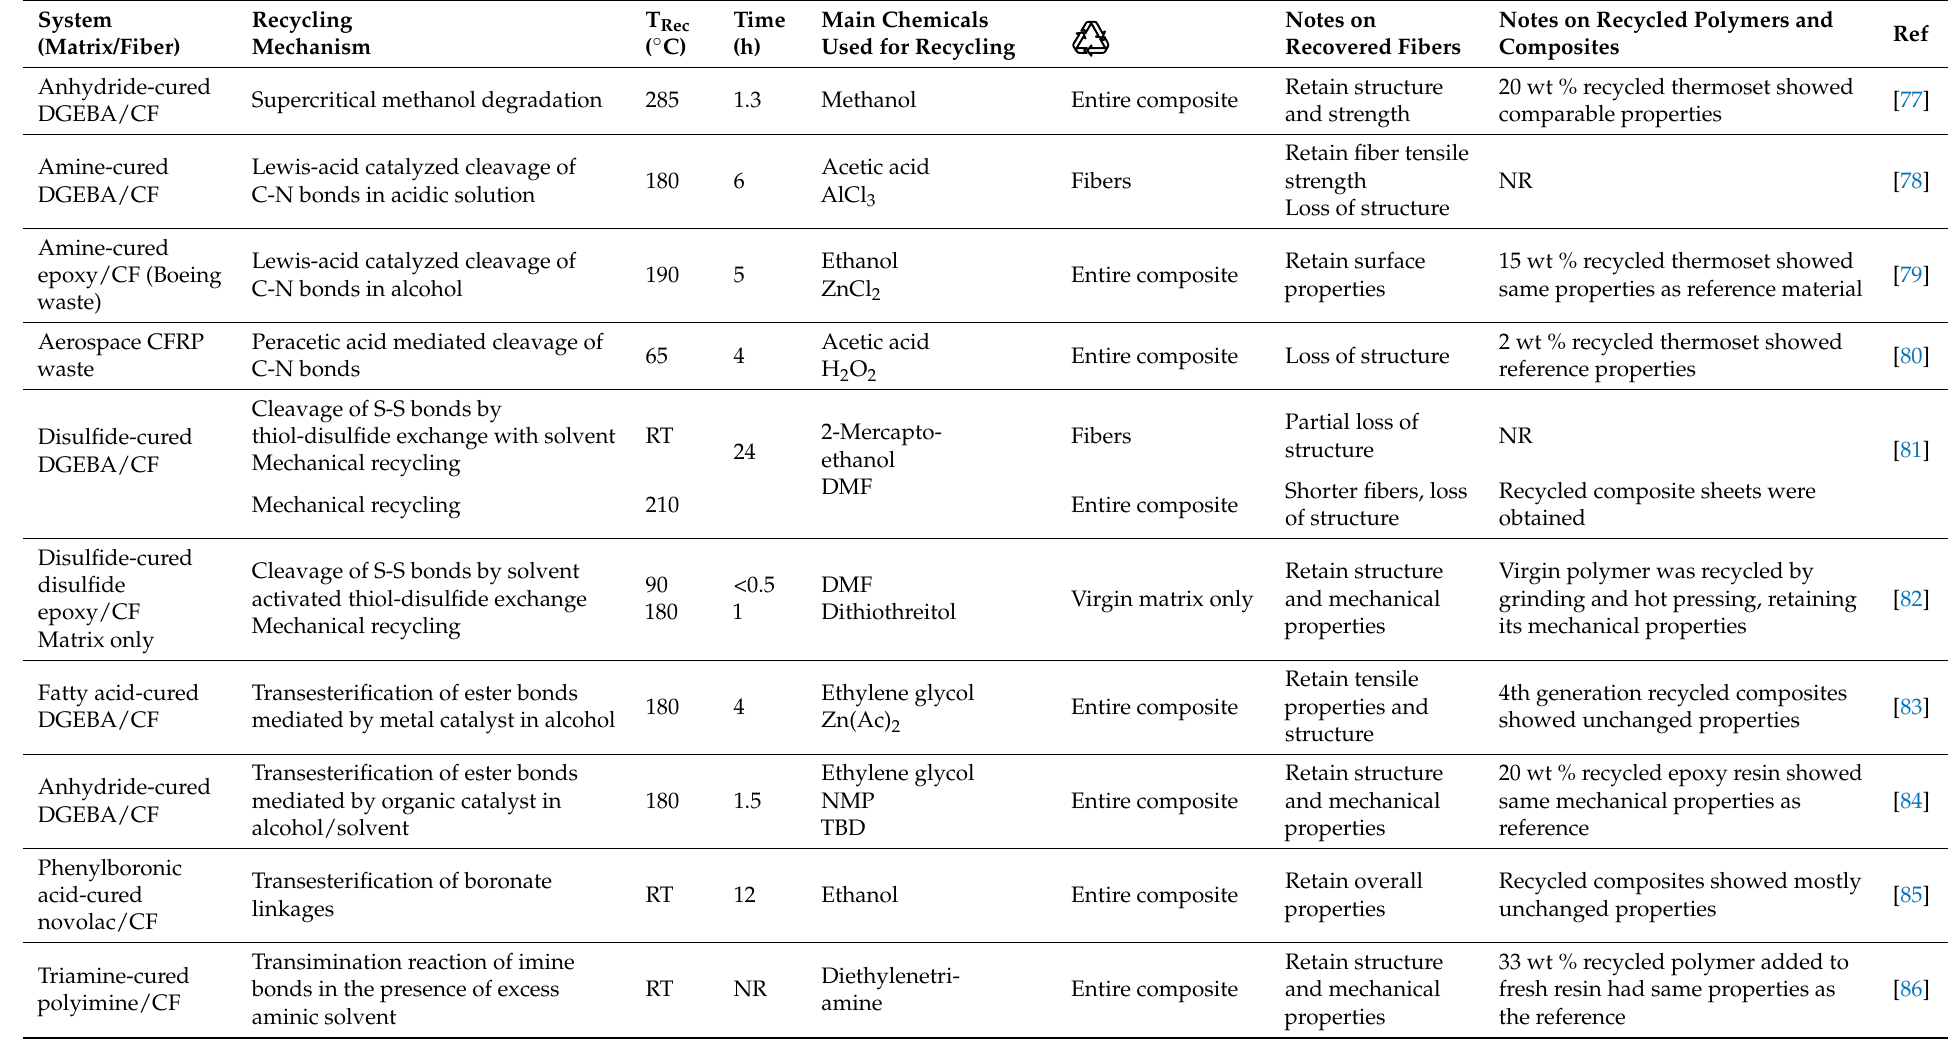
Table 4. Summary of reviewed works on the full recycling of TSFRPs, methodologies in use, and recycling